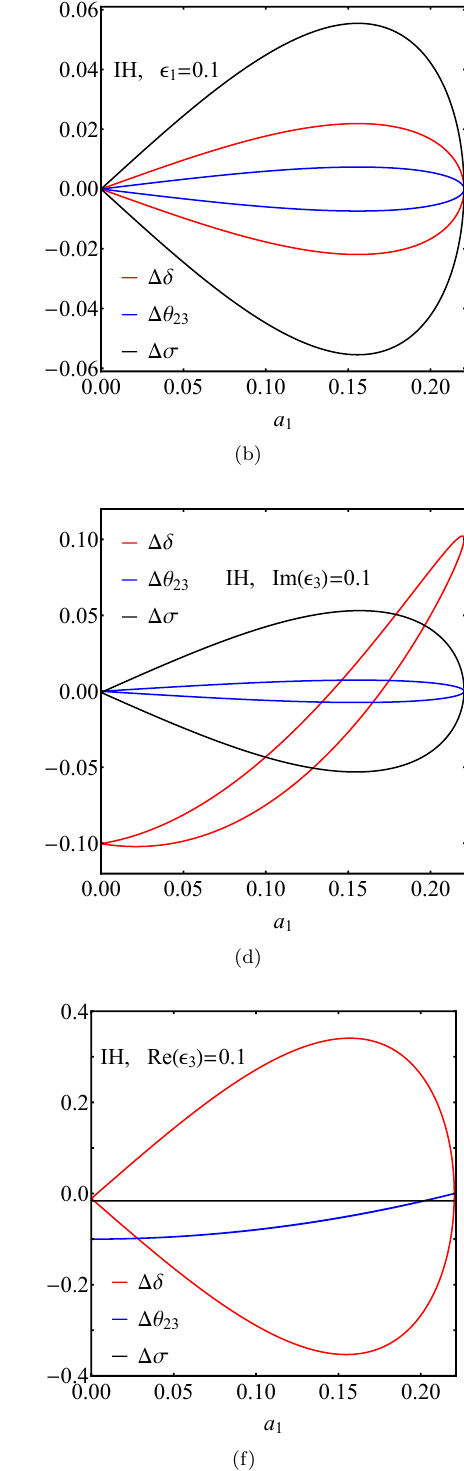
) induced by (cid:15) 1